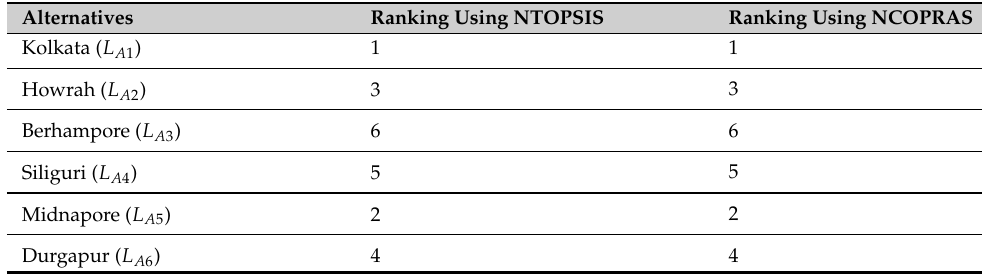
Figure 8. Pictorial of alternatives ranking by removing Accessibility ( ˜ m 6 ) . Table 21. Alternatives ranking by removing criteria Accessibility ( ˜ m 6 )